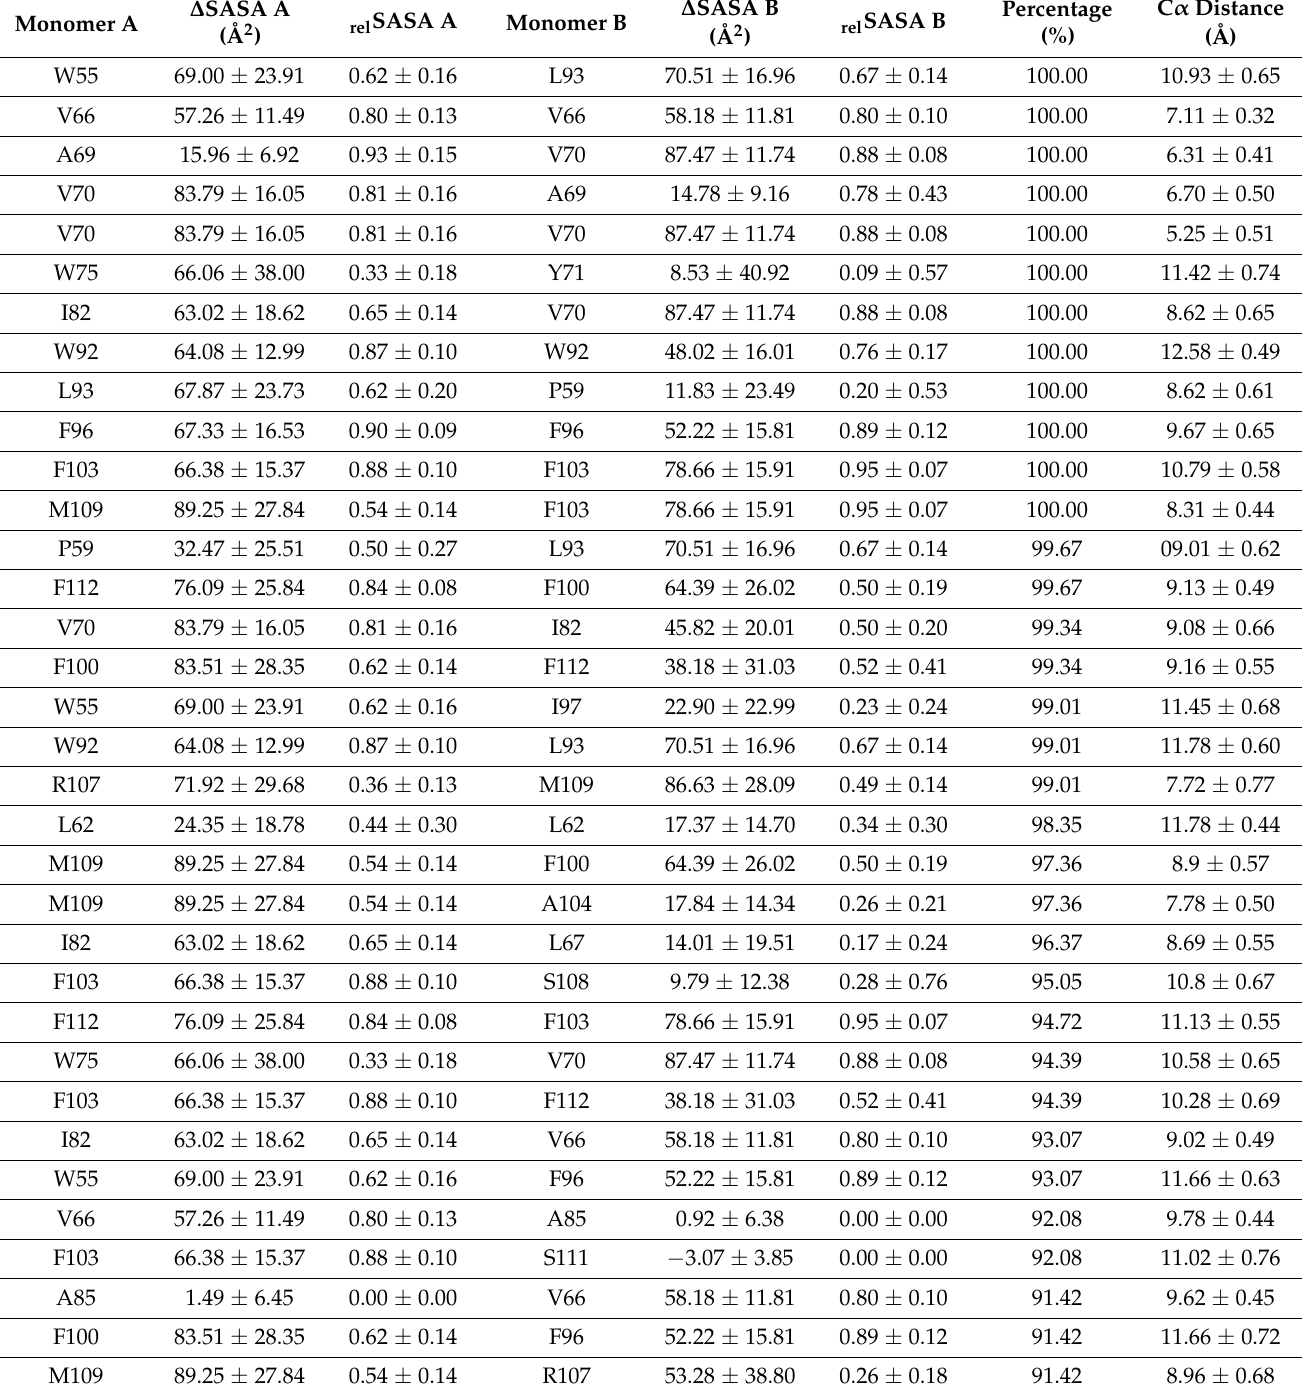
Table 1. SARS-CoV-2 M protein dimer interacting residues, using a prevalence time cut-off of 90% (all results were listed as mean values ± standard